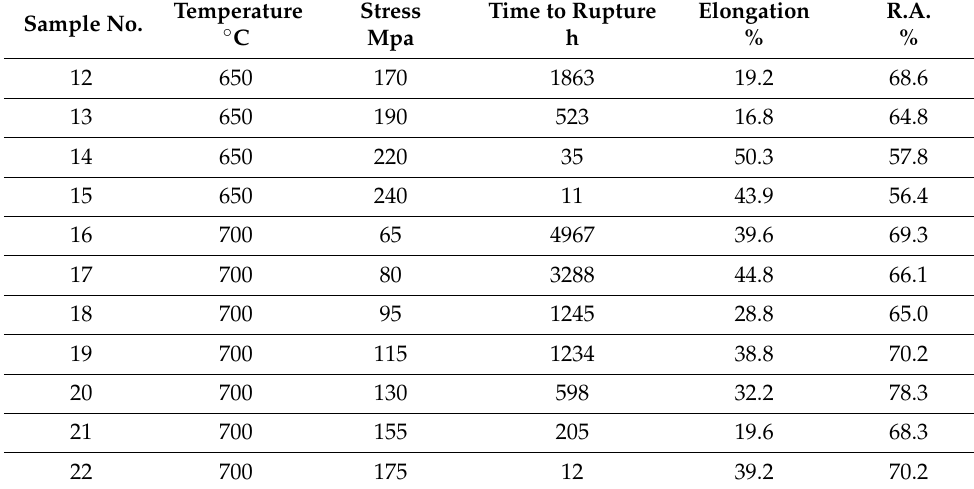
Table 4. Results of stress rupture tests of the hot-rolled AISI 316L steel plate. Sample